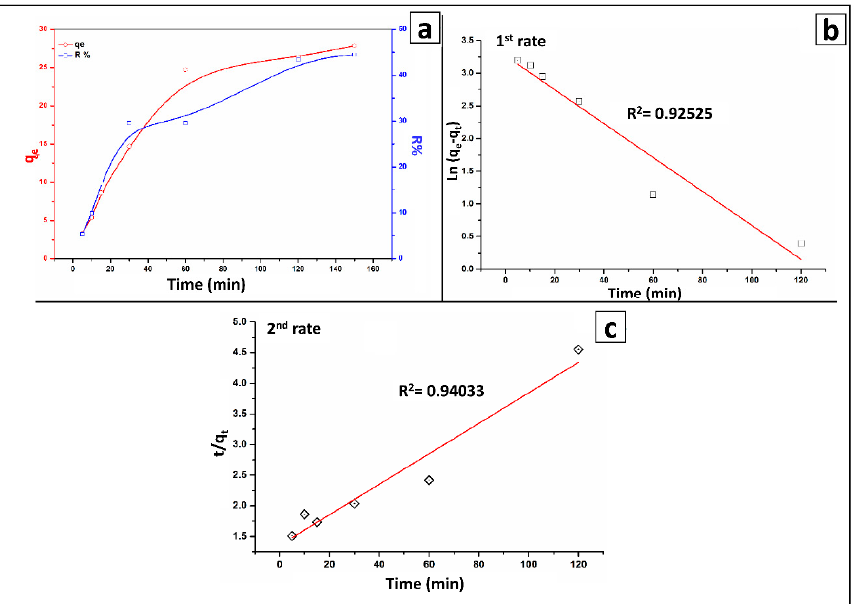
Figure 5. ( a ) Effect of time, ( b ) pseudo-first-order, ( c ) pseudo-second-order models for the adsorption of As(V) by the BT-An@Zetag composite.